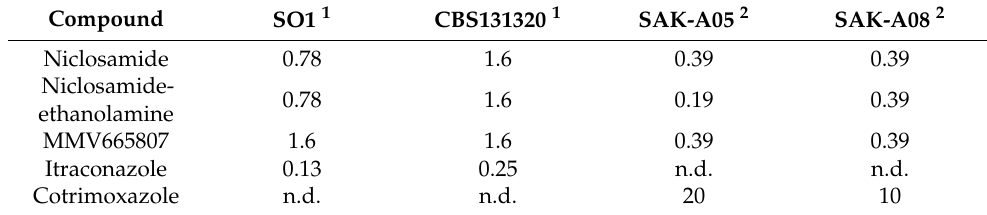
Table 2. In vitro activity of niclosamide and related compounds against causative agents of mycetoma: All assays were performed in triplicate. Values are MIC in µg/mL. Compound